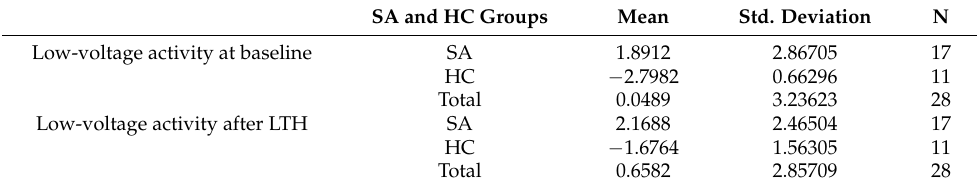
for both groups (SA and HCs). Table 9. Descriptive Statistics for Low